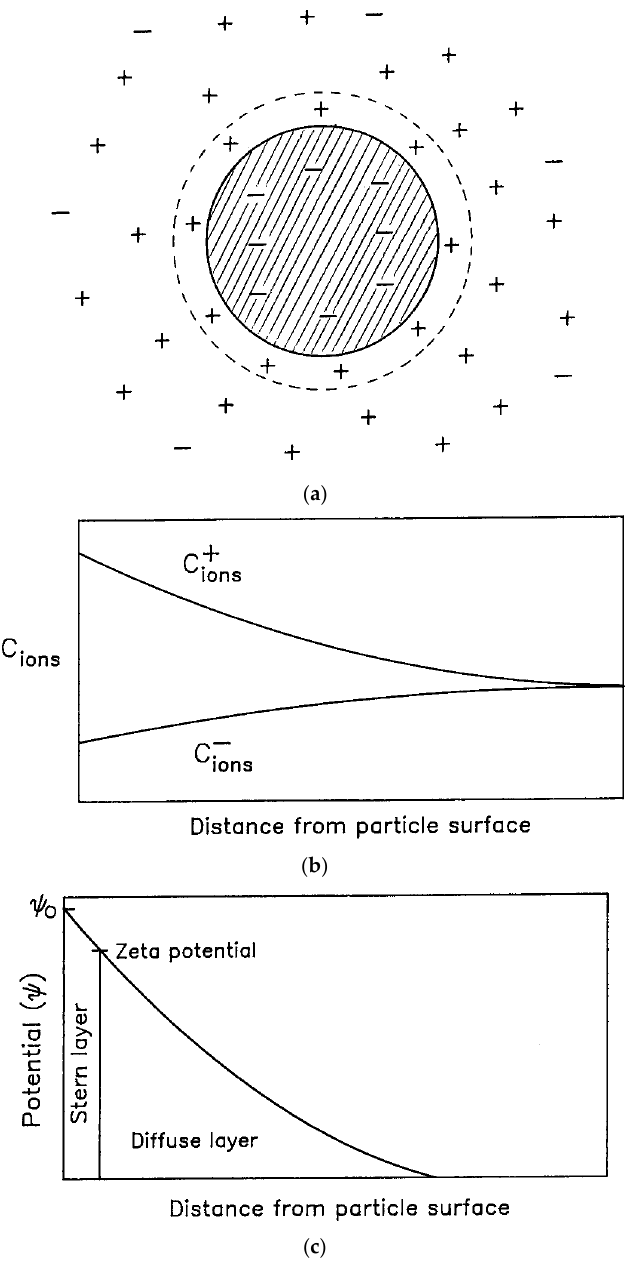
Figure 2. Charged particle surrounded by an ionic cloud [9]. Variations of ionic concentration and electric potential are also shown. ( a ) Charged particle surrounded by an ionic cloud; ( b ) Variation of ionic concentration with distance from the particle surface; ( c ) Variation of electric potential with distance from the particle surface.